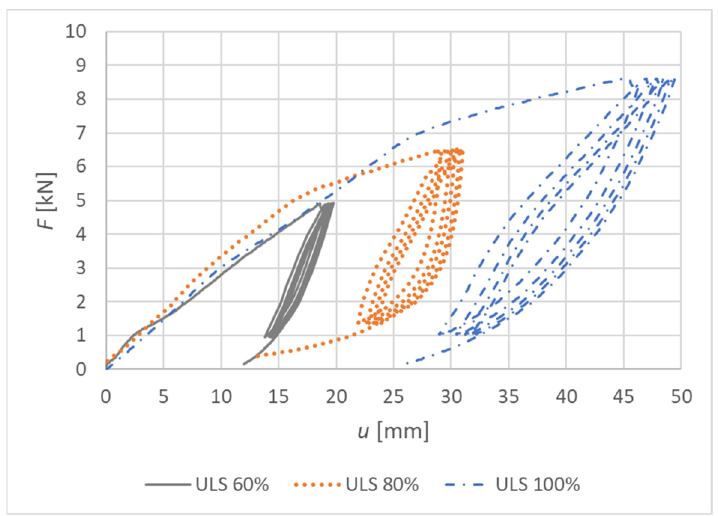
Figure 16. Load–deformation curves of nondestructive quasi-static cyclic testing for individual specimens made from a combination of bolts and dowels (Experiment A).